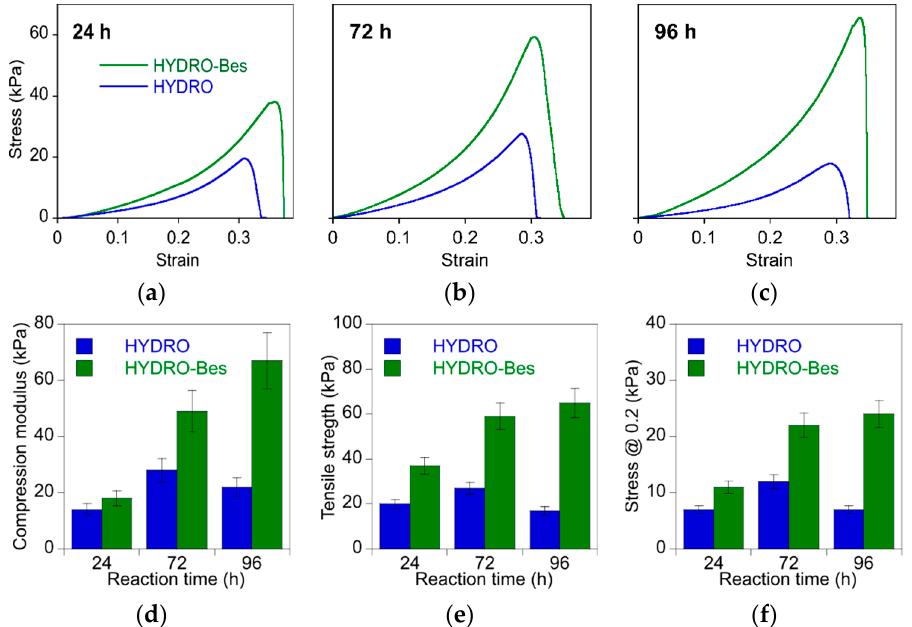
Figure 5. Mechanical characterization: ( a – c ) compression stress–strain curves for HYDRO and HYDRO-Bes at 24 h, 72 h, and 96 h of crosslinking, ( d ) compression modulus, ( e ) tensile strength, and ( f ) stress at 0.2 strain of HYDRO and HYDRO-Bes crosslinked for different